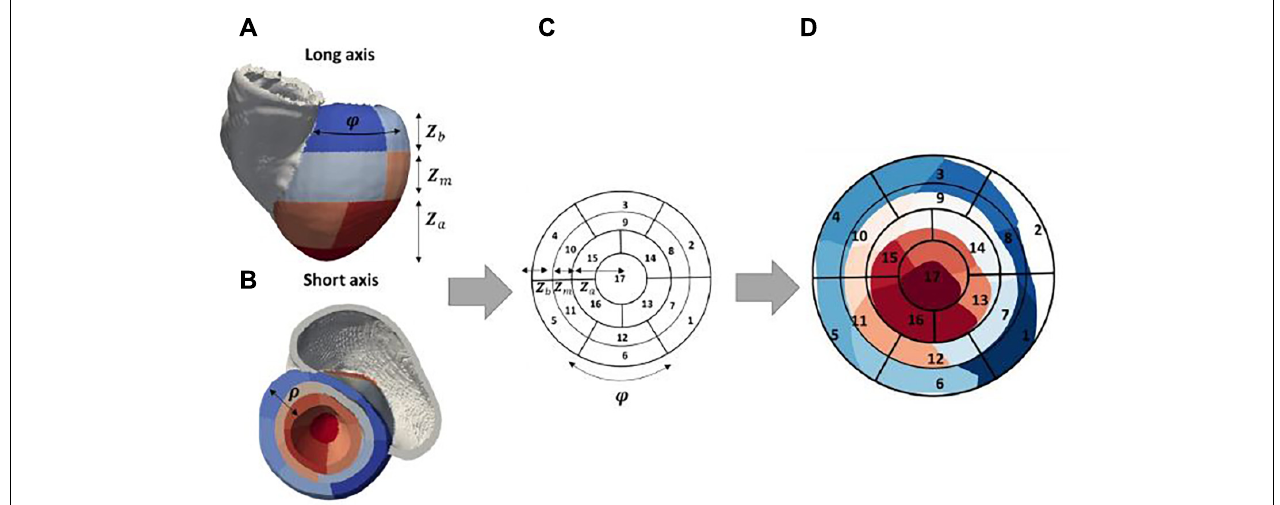
FIGURE 5 | Patient-specific bull’s-eye diagram. 3D patient-specific 17-segment model in (A,B) can be related to the 2D representation in (C) by considering UVC coordinates ϕ and z . Specifically, z (the distance from apex to base) can be linked to the radius of the 2D diagram, as shown, separately for each apical (Za), mid (Zm), and basal (Zb) part of the model. ϕ is linked to the segments along the spherical axis. The final patient-specific 2D 17-segment model can be seen in (D) , where the various segments (1–17) are illustrated from blue-to-red color range [mapped from panel B ].